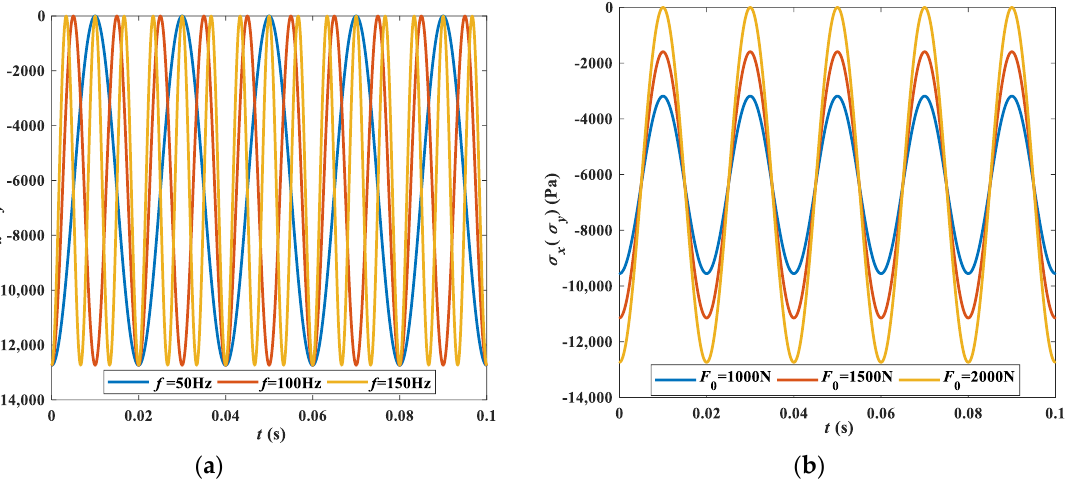
Figure 3. Far-field stress variation curves with time under different harmonic dynamic loads: ( a ) different frequencies; ( b ) different amplitudes.